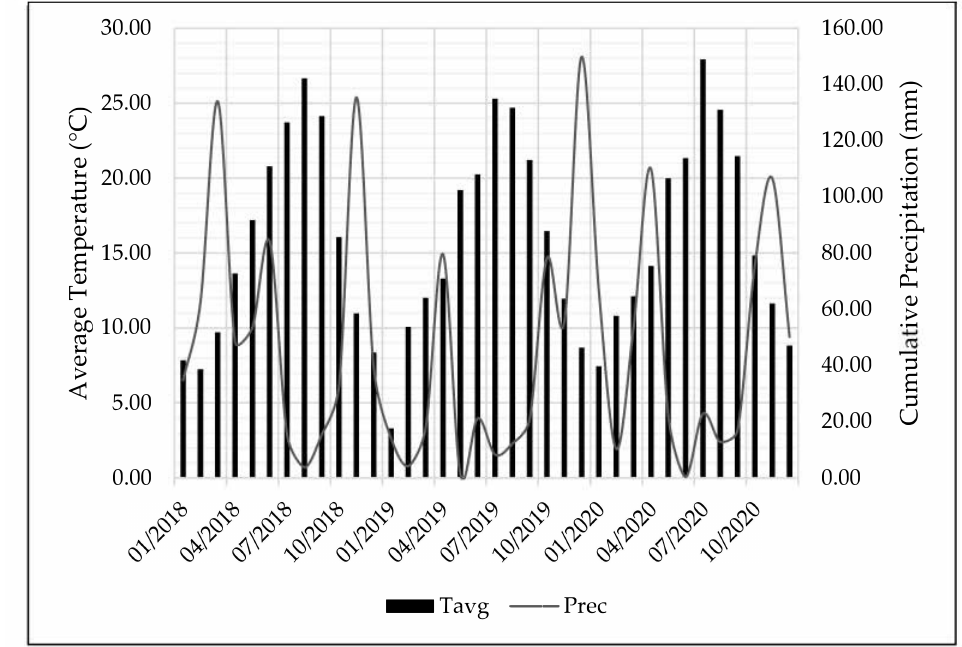
Figure A1. Monthly mean temperature ( ◦ C) and cumulative precipitation (mm) during the 2018 to 2020 seasons in the Douro superior